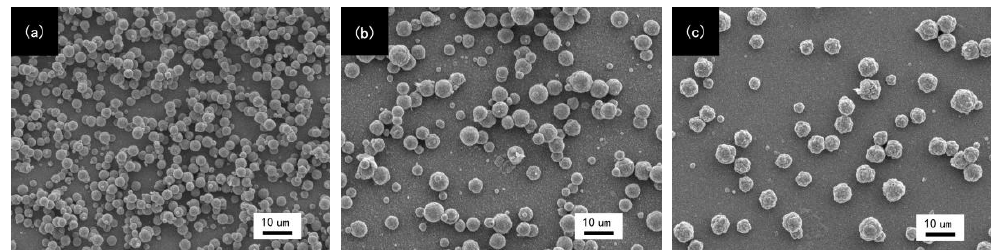
Figure 2. SEM images of copper film deposited on different SAMs modified ABS.